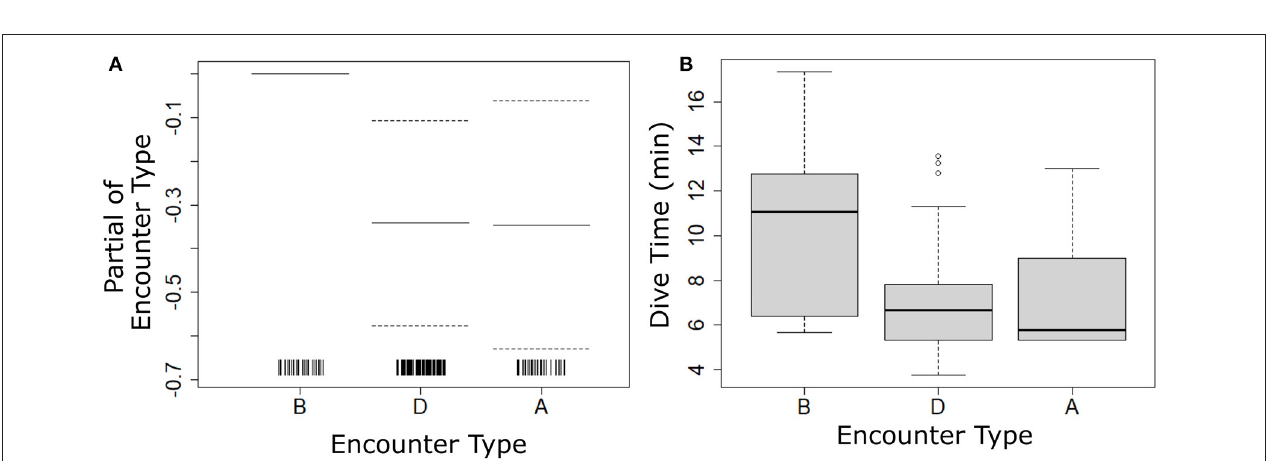
FIGURE 5 | Results from the best fit generalized additive model (GAM) for humpback whale dive time showing (A) model parameter estimates for encounter type (B-Before, D-During, A-After) and (B) model predicted dive times based upon encounter type. Dashed lines in image (A) represent the 95% confidence intervals of the parameter estimate, and vertical ticks indicate the locations of observations (i.e., a rugplot).